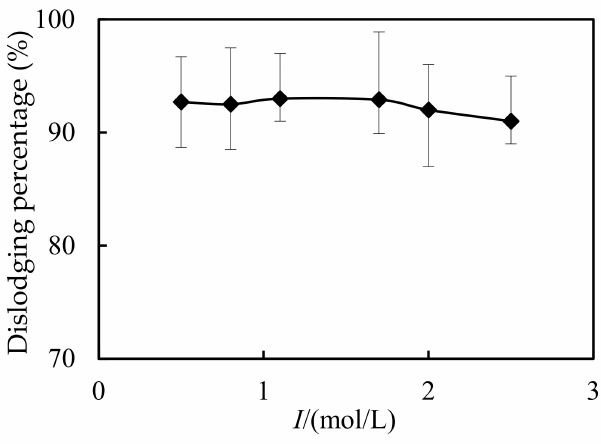
Figure 10. Impact of ion intensities on dislodging of Cd(II).